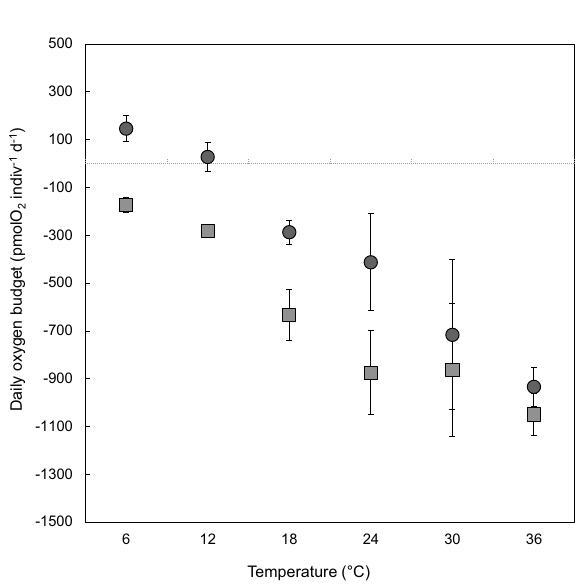
Figure 7. Daily oxygen budget of H. germanica (pmolO 2 indiv −1 day −1 ) under 12 h (black dots) and 6 h (grey squares) light exposure and thermal regimes. The error bars are the standard errors calculated on the 3 replicates at each